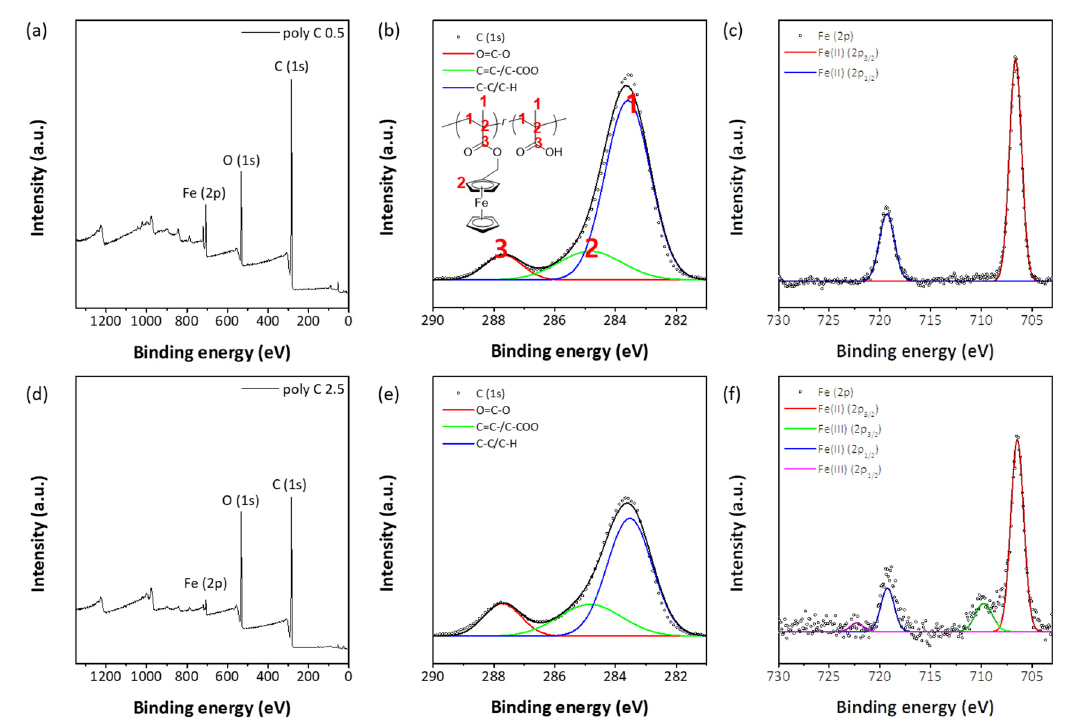
Figure 4. XPS spectra of electrospun / sprayed poly C0.5 and poly C2.5 samples, ( a , d ) survey spectra, ( b , e ) C 1s multiplex spectra, and ( c , f ) Fe 2p multiplex spectra, respectively.